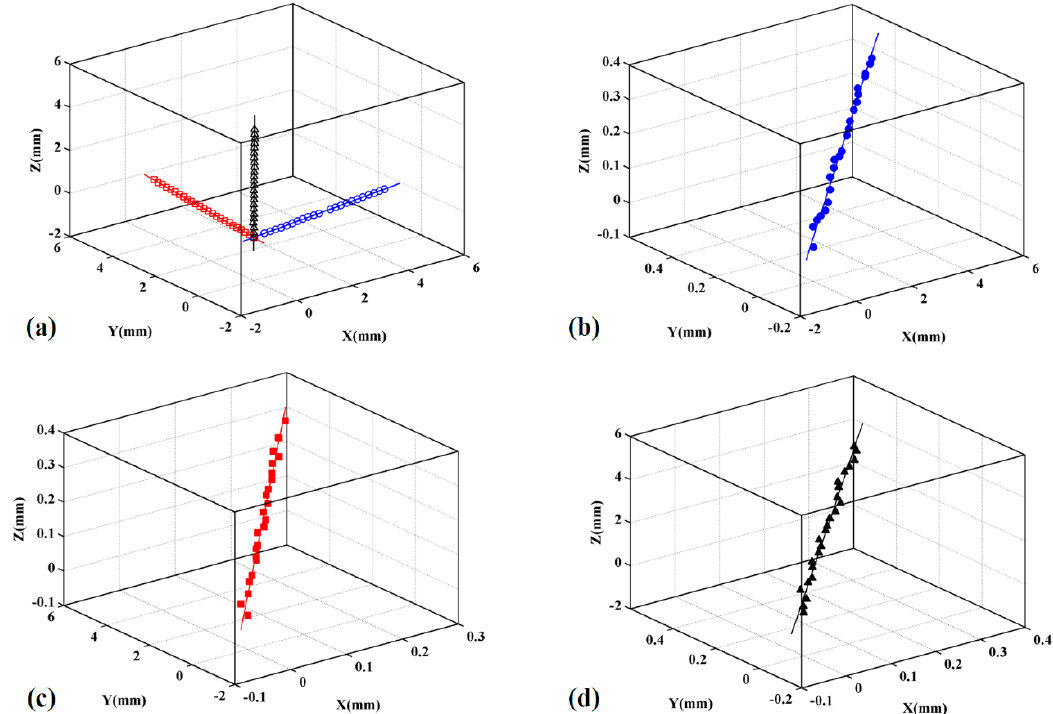
Figure 7. The fitted motion trajectory line in the X-, Y- and Z- directions. The three initial standard motion trajectory lines with 25 sampled points in each line were preset firstly which have the unit vectors along the X-, Y- and Z-axis, respectively. The angle between the two adjacent motion trajectory lines is initialized by 87.728 degrees. ( a ) The vectors of the sample points measured by the laser displacement sensors constructed three measured trajectory lines. ( b ) The fitted line is obtained based on the X-direction data; ( c ) The fitted line is obtained based on the Y-direction data; ( d ) The fitted line is obtained based on the Z-direction data. Table 4. The results of angle measurement between moving trajectories.